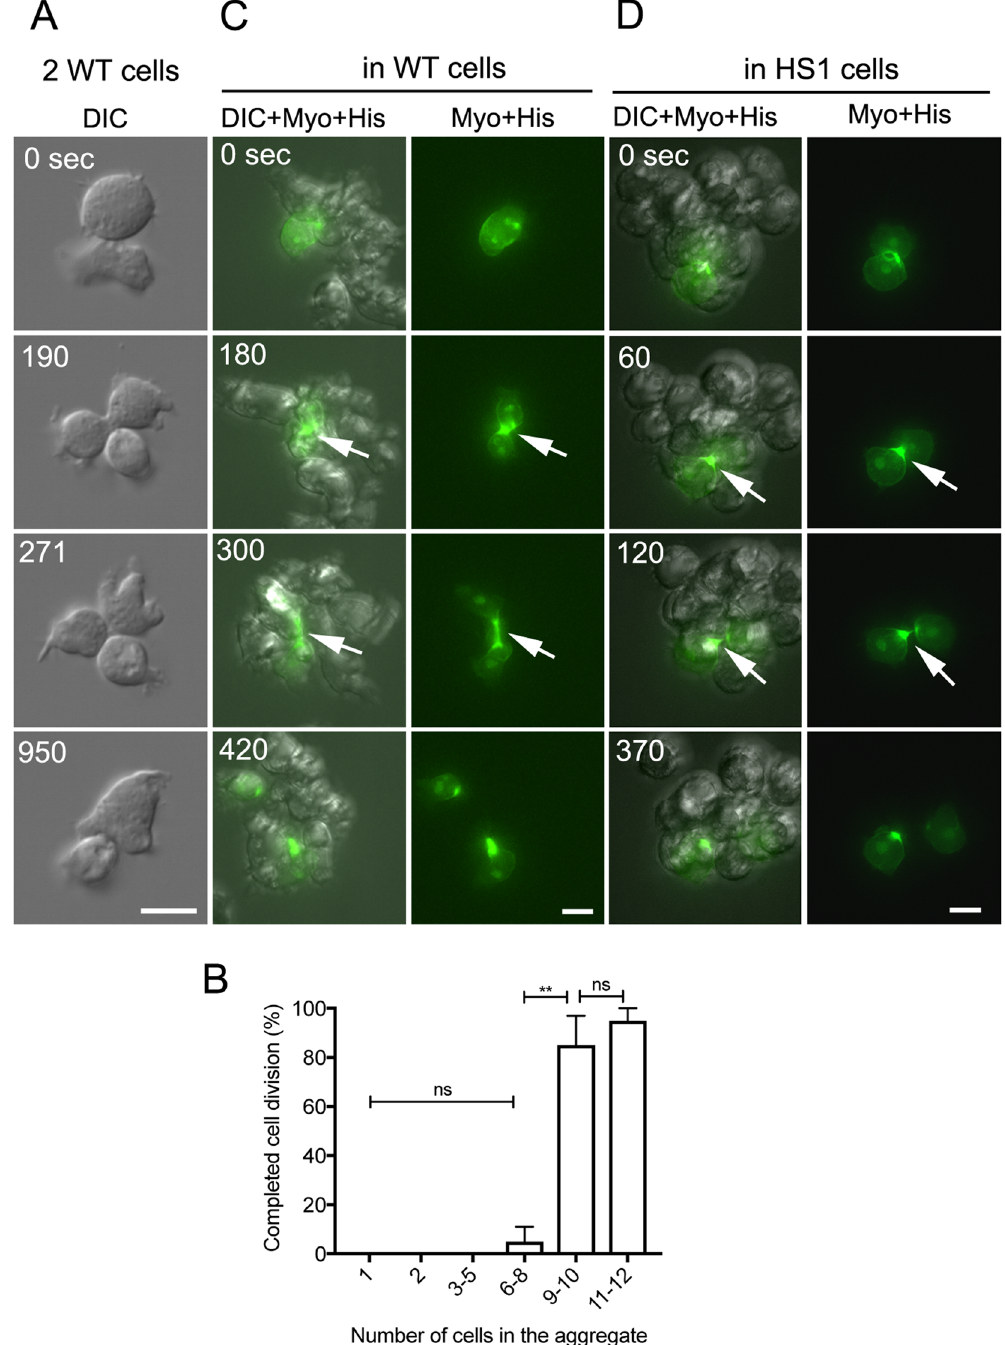
Figure 4. Observation of cell division in multicellular aggregates. ( A ) When the dividing cell adhered to another single cell, it formed the cleavage furrow but eventually failed in cytokinesis. ( B ) Frequency of successfully completed cell division depending on the number of cells composed of the aggregate. Data are presented as mean ± SD in five independent experiments (n = 30 dividing cells, each). ** P ≤ 0.001; ns, not significant, P > 0.05. ( C ) Typical time course of wild-type cell division in a multicellular aggregate. Wild-type cells simultaneously expressing GFP-myosin II and GFP-histone were mixed with wild-type cells not expressing GFPs at a ratio of 1:100. The fluorescence images were acquired by z-sectioning at 1- μ m intervals over time under a sectioning fluorescence microscope and then reconstituted into three-dimensional images. Merged images of GFP-myosin II, GFP-histone, and DIC (left column) and of GFP-myosin II and GFP-histone (right column) are shown. Note that the fluorescent cell completed cytokinesis and that myosin II accumulated at the furrow (arrows) in the multicellular aggregate (composed of 9 cells). ( D ) Typical time course of wild- type cell division in a multicellular aggregate of myosin II-null cells (composed of 10 cells). Wild-type cells simultaneously expressing GFP-myosin II and GFP-histone were mixed with myosin II-null cells not